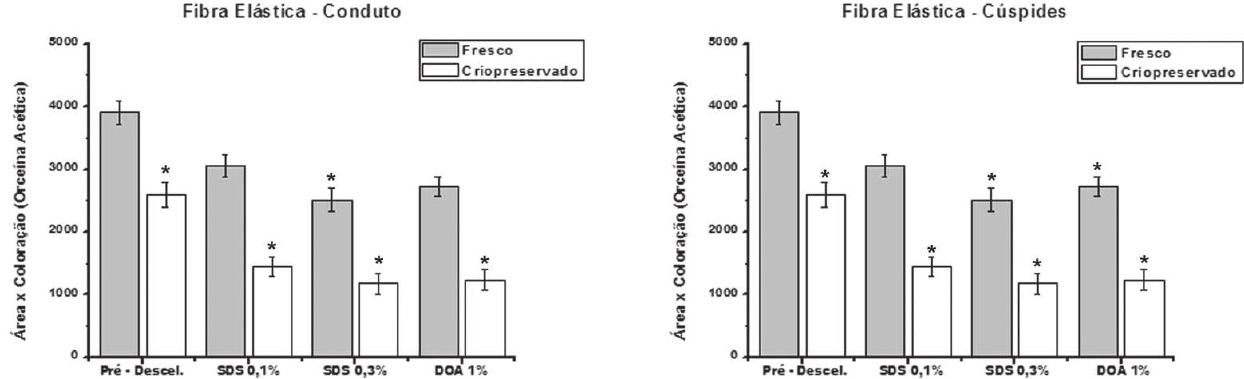
Fig. 3 - À esquerda: análise morfométrica de lâminas de conduto de ambos os grupos I e II, respectivamente, coradas com orceína acética para observação quantitativa de fibras elásticas. À direita: análise morfométrica de lâminas de cúspide dos grupos I e II, respectivamente, coradas com orceína acética para observação quantitativa de fibras elásticas. * = P< 0,05